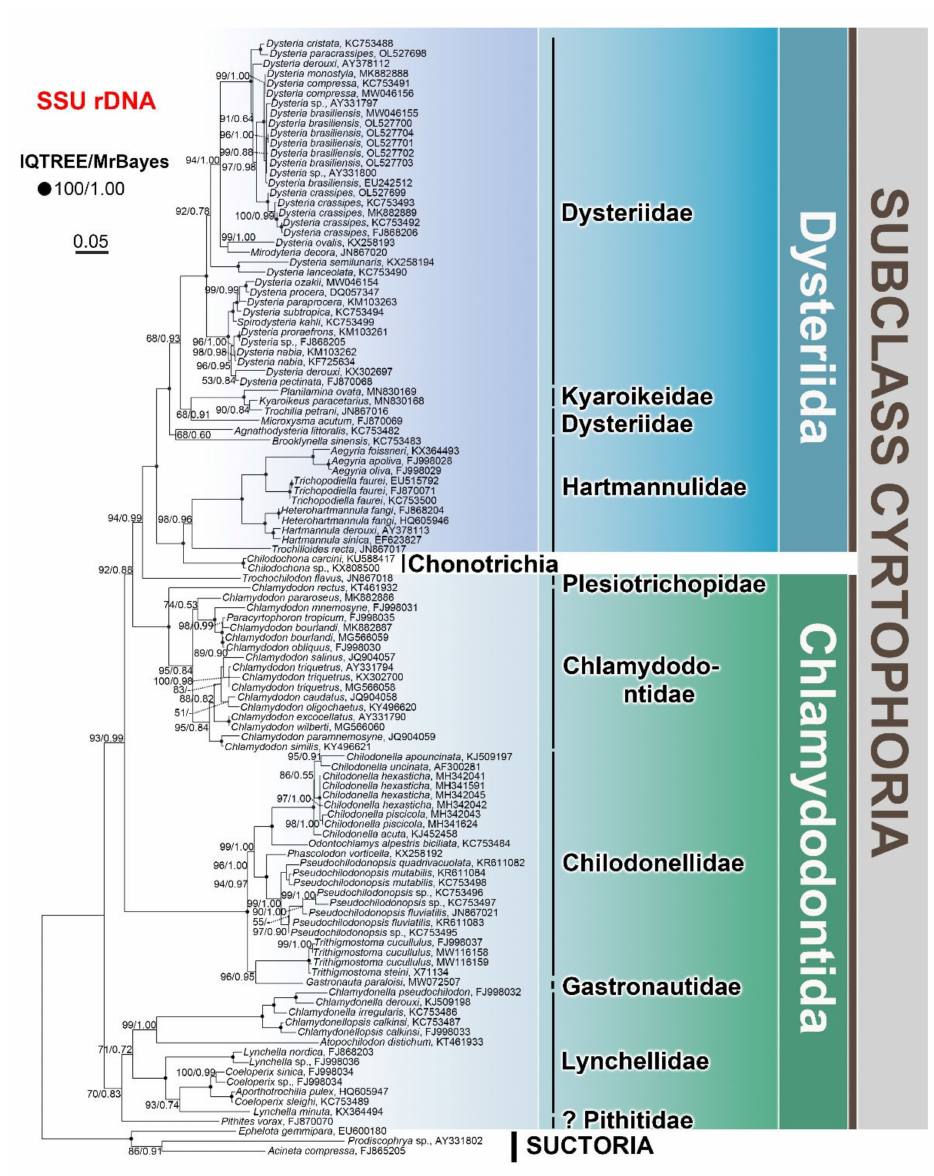
Figure 5. Phylogenetic tree inferred from SSU rDNA sequences. The trees were reconstructed by two algorithms: IQTREE and MrBayes. Support values from the two methods are provided at the branching points (IQTREE/MrBayes). Bold dots at the branching points indicate full support from both analyses. “-” indicates discrepancy between the topologies of IQTREE and the MrBayes trees. The scale bar represents five substitutions per hundred nucleotide